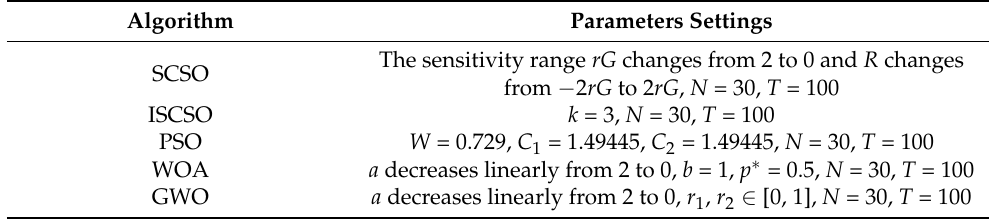
Table 3. Parameters Settings.